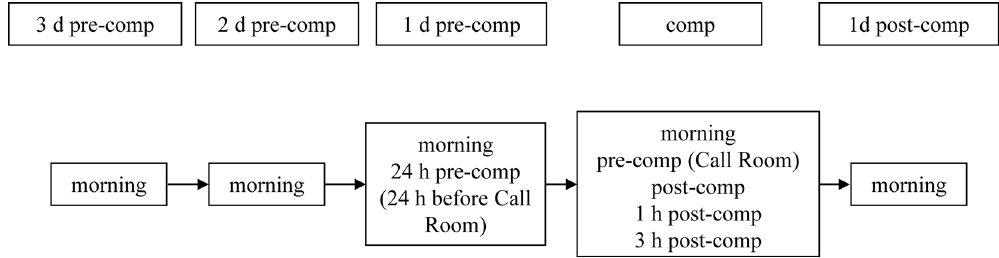
Figure 1. Saliva sample schedule. Upper boxes represent day of sampling, lower boxes state the sampling times of the respective day. Upper boxes: 3 d, 2 d and 1 d pre-comp = three, two and one day before the day of the competition, respectively, comp = day of the competition, 1 d post-comp = first day after the competition. Lower boxes: morning = morning of the sampled day directly after waking up, 24 h pre-comp = 24 h before entering the Call Room, pre-comp = before entering the Call Room, post-comp = immediately